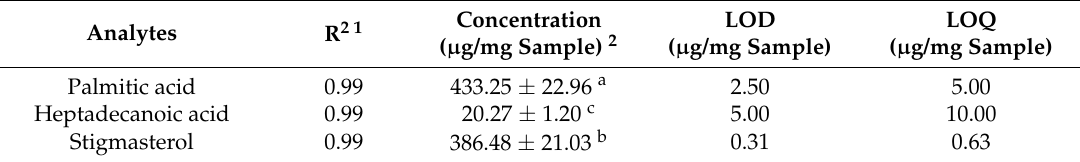
Table 4. Calibration curves, detection limits and quantification limits measured by GC-MS. Analytes R 2 1 Palmitic